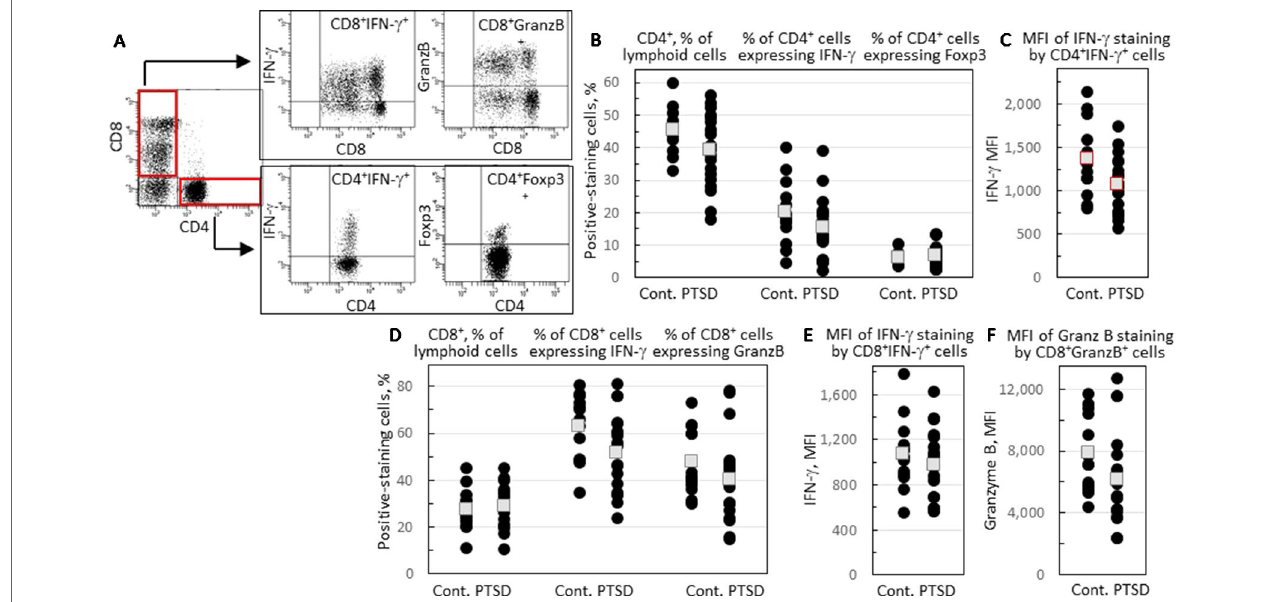
FIGURE 1 | Comparison of levels of CD4 + and CD8 + cells and the proportion of these cells that express immune mediators. (A) A representative illustration of the gating strategy. Lymphoid cells were stained for CD4 and CD8 expression and identified in red-outlined quadrants as CD4 + CD8 - or CD8 + CD4 - cells. Gated CD4 + CD8 - cells were further analyzed for IFN- γ and Foxp3 staining, and gated CD8 + CD4 - cells analyzed for IFN- γ and granzyme B (GranzB) staining. (B) The percentages of CD4 + CD8 - cells, and the percentages of gated CD4 + CD8 - cells that express IFN- γ or Foxp3. (C) The mean fluorescence intensity (MFI) of IFN- γ staining by gated CD4 + CD8IFN- γ + cells. (D) Percentages of CD8 + CD4 - cells, and the percentages of gated CD8 + CD4 - cells that express IFN- γ or granzyme B. (E) MFI of IFN- γ staining by gated CD8 + CD4 - IFN- γ + cells. (F) MFI of granzyme B staining by gated CD8 + CD4 - cells. Shown as black circles are data for each research subject, with the mean values shown as squares. Mean values that are statistically different between Veterans with and without PTSD are shown as red